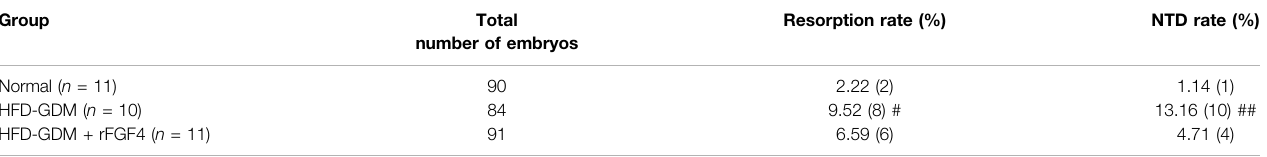
TABLE 2 | rFGF4 treatment alleviates NTD formation of HFD induced GDM mice.